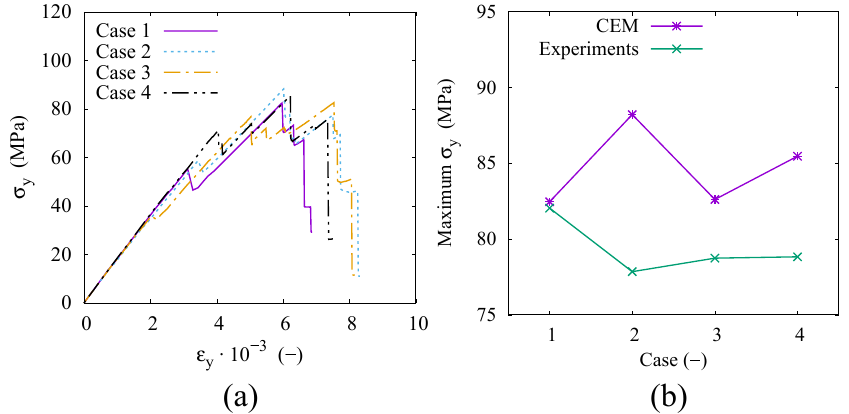
Figure 6. Sandstone containing three pre-existing fissures: ( a ) force–displacement curves; ( b ) maximum vertical loads compared to the experimental results provided in [82].